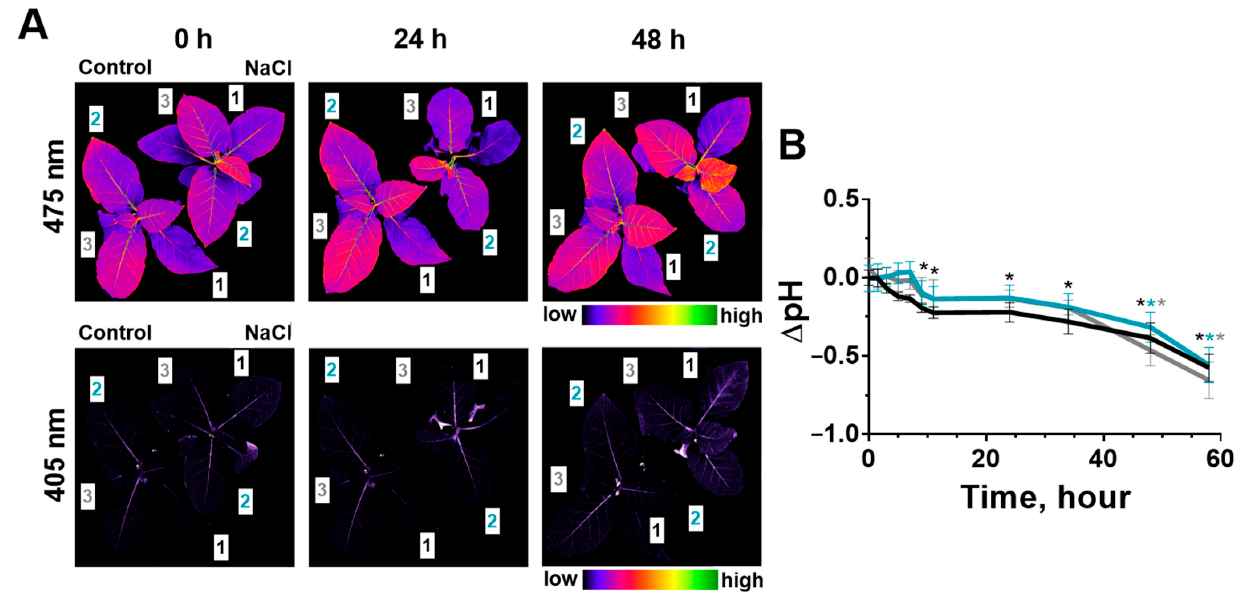
Figure 5. Change in fluorescence of the Pt-GFP sensor and cytosolic pH in different stratum of tobacco leaves (1, 2, 3) during salinity. ( A ) Changes in transgenic plant fluorescence (excitation of 475 and 405 nm) are demonstrated as whole-plant imaging in the pseudo-color scale in control (Control) and salt-treated (NaCl) plants at three time points (0, 24 and 48 h) of salt stress. Cytosolic pH ( B ) increased relative to control (water-treated plants) values (leaves: 1—black, 2—blue, 3—gray). The data are presented as mean ± SEM (n = 9), * p < 0.05 control versus salt treatment. Salinity had also caused acidification of the leaf cytosol in potato plants (Figure 6B).